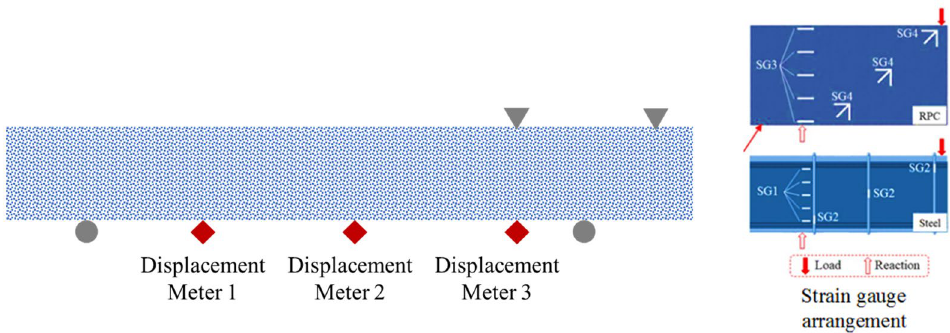
Figure 3. Arrangement of the strain gauge and displacement